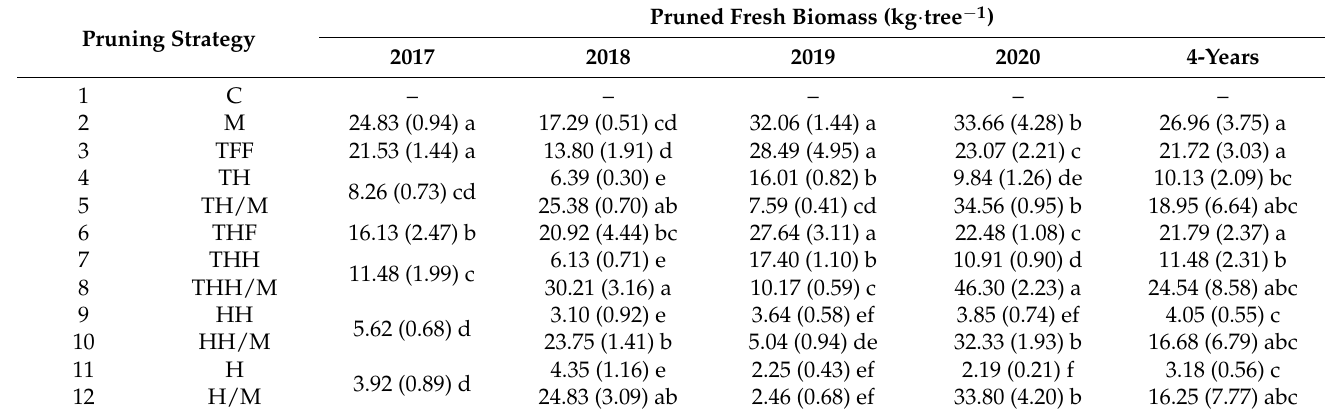
Table 6. Pruned fresh biomass (kg · tree − 1 ) by pruning strategy for each year and for the four years overall. Data are expressed as averages, with standard errors in parentheses. Different letters between pruning strategies indicate significant differences ( p < 0.05) according to Fisher’s LSD test for each year 1 and according to median notched box plot for the 4-year overall 2